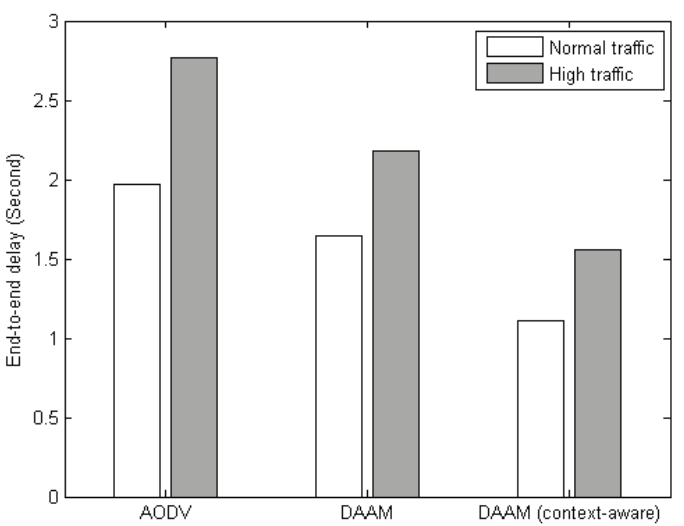
Figure 12. End-to-end delay of NET protocols.